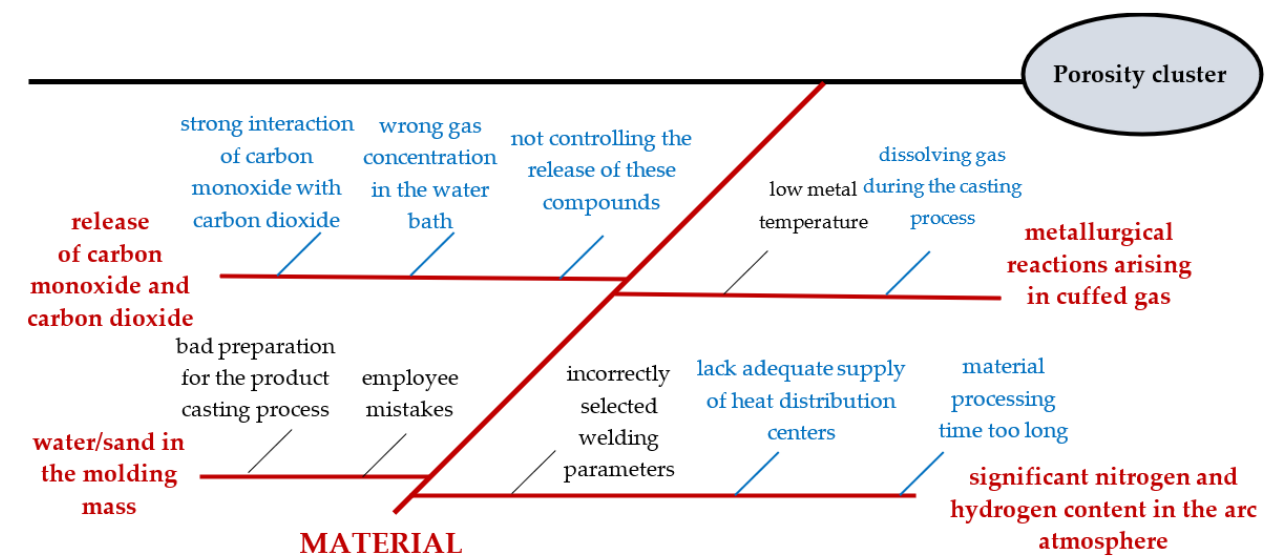
Figure 7. Result of the DEMATEL analysis combined with the Ishikawa diagram.